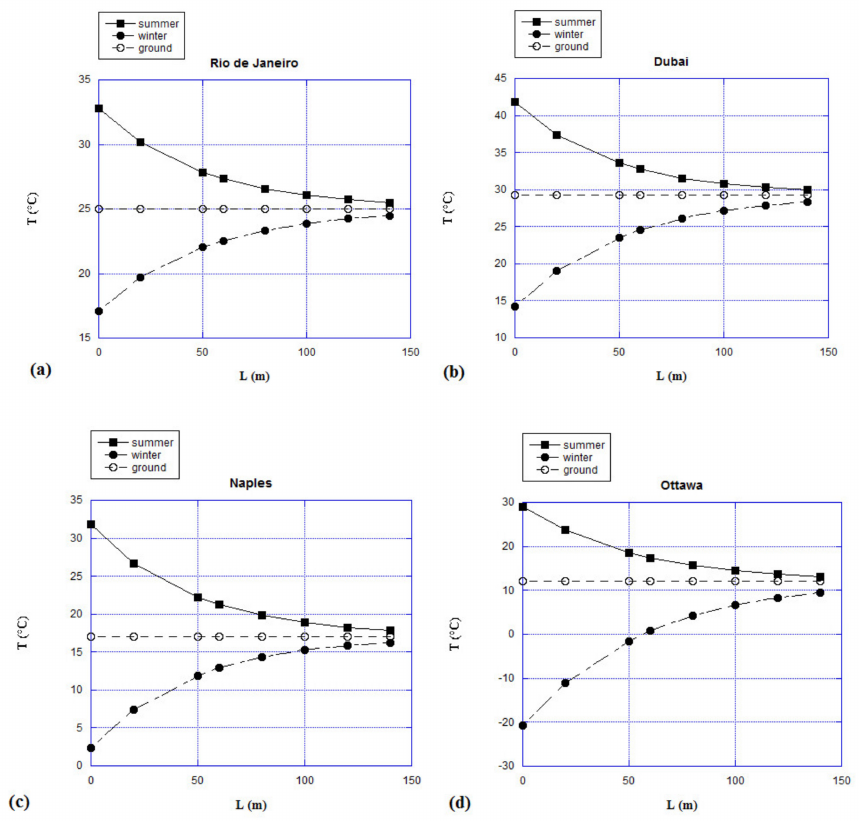
Figure 10. Temperature of the air flowing with 2.5 m s − 1 velocity into the GAHX as a function of tube length in winter and summer season for: ( a ) Rio de Janeiro; ( b ) Dubai; ( c ) Naples ( d ) Ottawa.